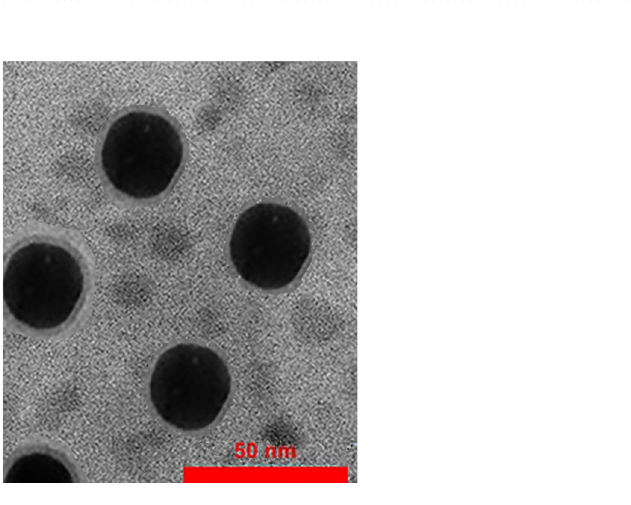
Figure 2. TEM image of synthesized Ag/ZnO/Amodiaquine nanoparticles.